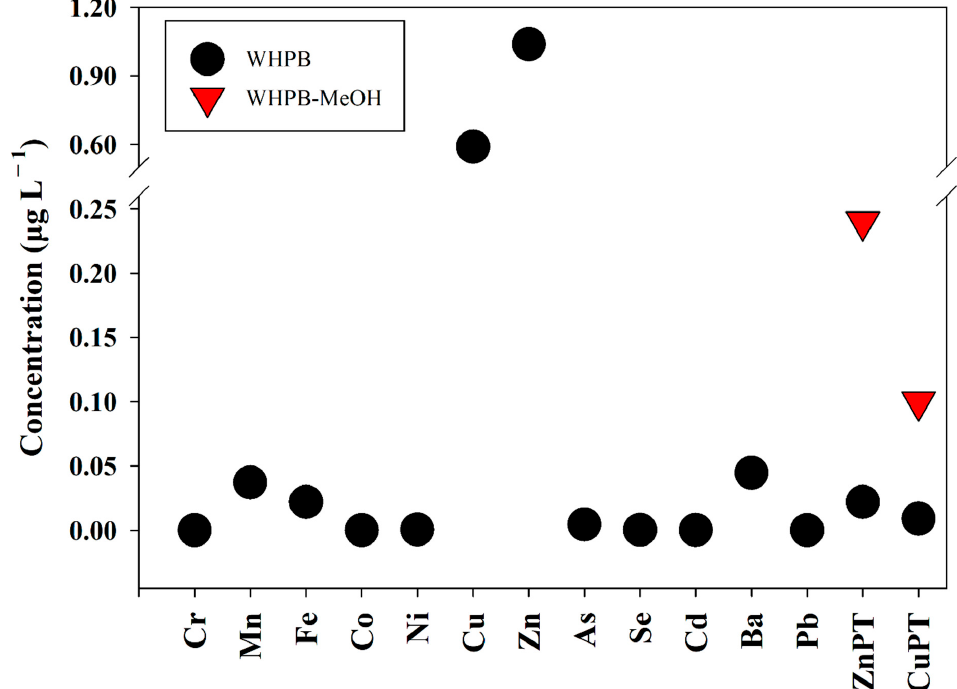
Figure 3. Expected concentration of metallic elements and booster biocides in wastewater (black circle: WHPB; red triangle: WHPB-MeOH) from high-pressure water blasting at 24 h LC 50 values for Paracalanus parvus sl. We analyzed the toxic effects of WHPB relative to the three booster biocides, which were prohibited or banned in some European countries [41,42]. As de- scribed in the previous paragraph, the 24 h LC 50 concentrations of Diuron, Irgarol 1051, and Sea-nine 211 affecting hatched larvae were 1.97, 1.39, and 0.0004 mg L − 1 , respectively. By contrast, the 24 h LC 50 concentrations of ZnPT and CuPT in WHPB affecting the egg- hatching rate were found to be 0.02 and 0.01 μ g L − 1 , respectively. This result confirms that WHPB toxicity for the egg-hatching rate and nauplius mortality of P. parvus sl is stronger for Sea-nine 211, which was 3000 times more toxic than Irgarol 1051 and Diuron in the present study. 4. Conclusions In this study, we aimed to determine the acute toxicity effects on the egg-hatching rate and nauplius mortality of P. parvus sl exposed to three types of booster biocides and WHPB. Sea-nine 211 was confirmed to be more toxic than Irgarol 1051 and Diuron. How- ever, even Sea-nine 211 was found to have approximately 20 times lower acute toxicity effects than WHPB (ZnPT-based antifouling paint) obtained using a brush from the ship’s hull surface. Therefore, assuming that the entire hull surface of a container ship with a length of more than 200 m is cleaned, hundreds of tons of wastewater would be dis- charged into the port water, which is expected to profoundly impact the port environment and ecosystem, considering the results of this study that WHPB affects the egg-hatching rate and nauplius mortality of P. parvus sl even when diluted more than 1000 times. Fur- thermore, wastewater contains a large number of antifouling paint particles, which are